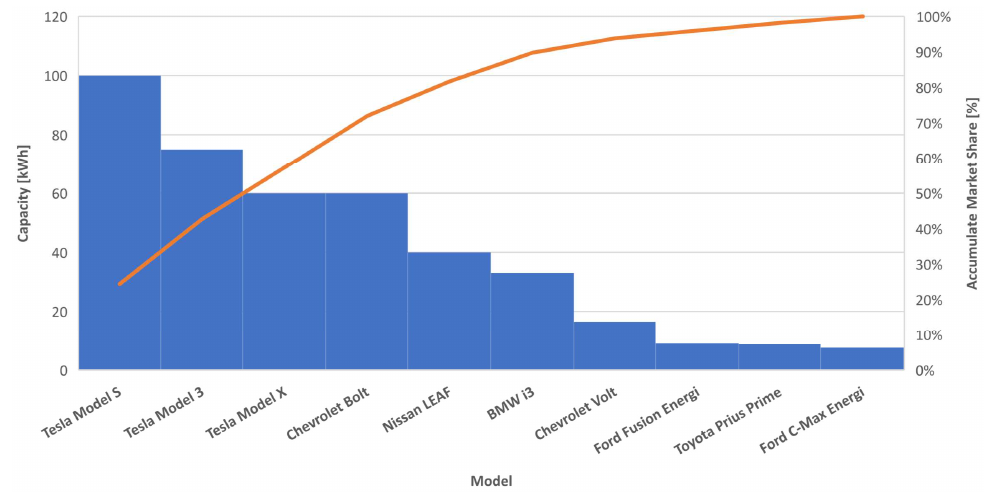
Figure 3. The top best selling cars and their rated capacities.